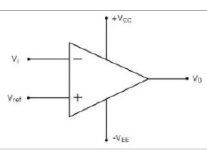
Figure 5. Comparator circuit